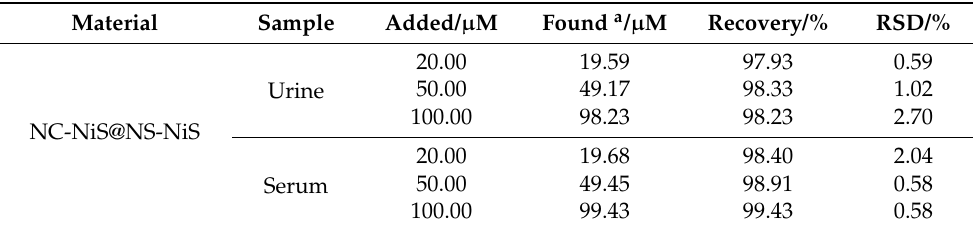
Table 2. Real sample analysis of glucose sensor in practical human urine and serum samples ( n =